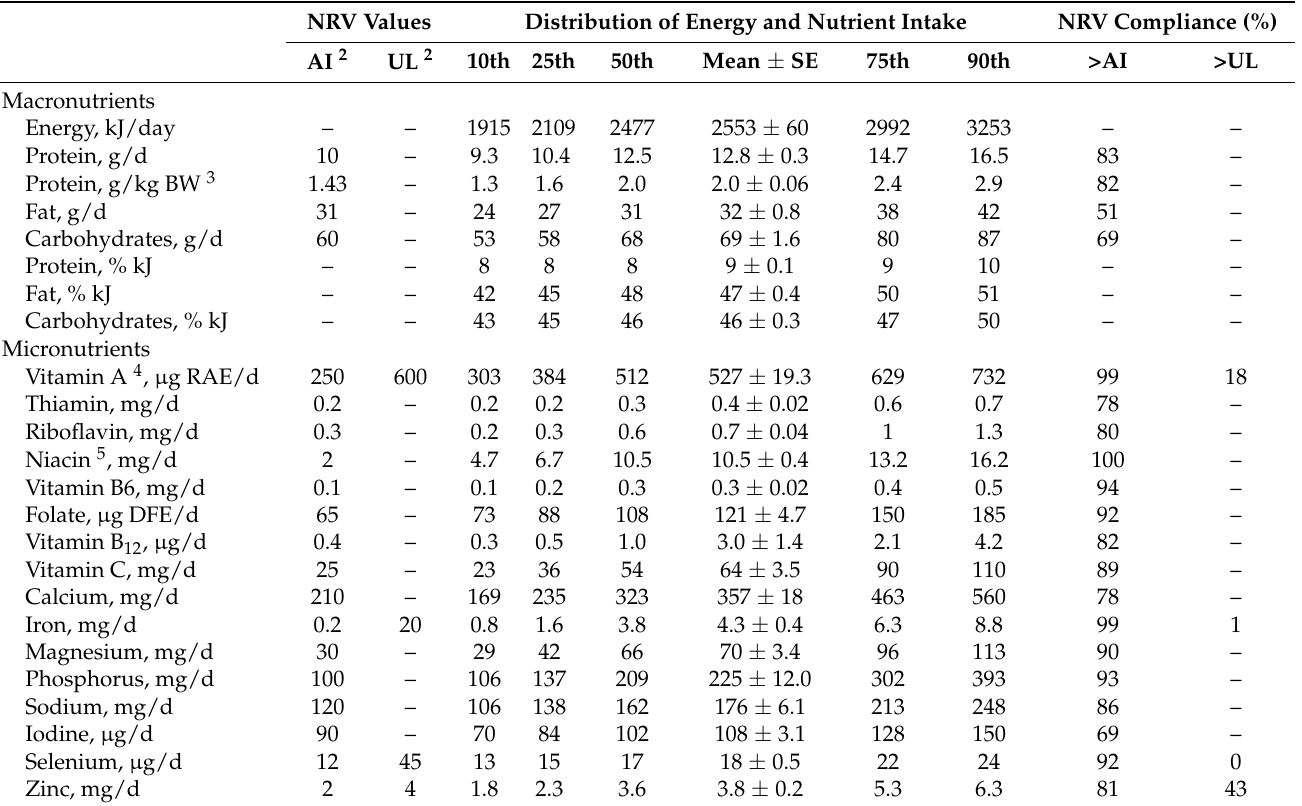
Table 2. Usual energy and nutrient intake distribution from foods and beverages for mixed